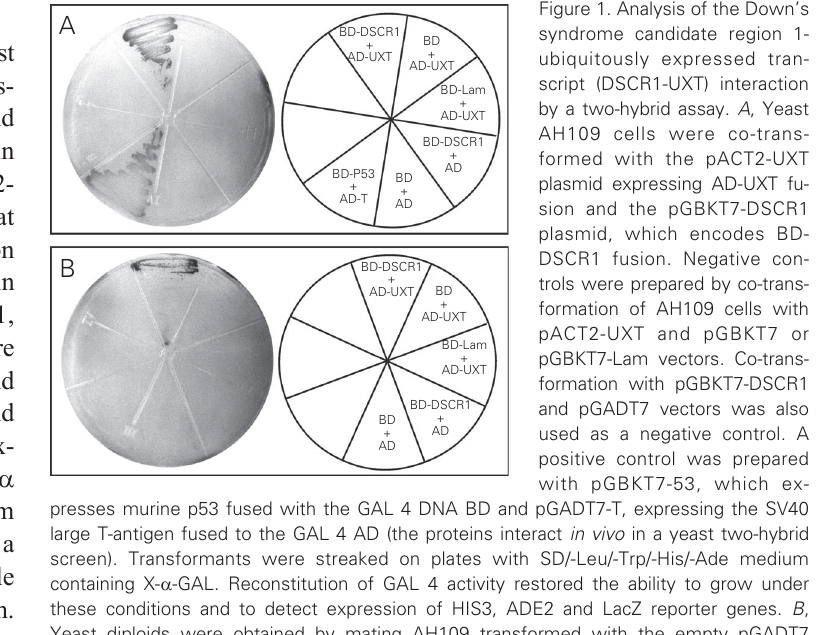
Figure 1. Analysis of the Down’s syndrome candidate region 1- ubiquitously expressed tran- script (DSCR1-UXT) interaction by a two-hybrid assay. A , Yeast AH109 cells were co-trans- formed with the pACT2-UXT plasmid expressing AD-UXT fu- sion and the pGBKT7-DSCR1 plasmid, which encodes BD- DSCR1 fusion. Negative con- trols were prepared by co-trans- formation of AH109 cells with pACT2-UXT and pGBKT7 or pGBKT7-Lam vectors. Co-trans- formation with pGBKT7-DSCR1 and pGADT7 vectors was also used as a negative control. A positive control was prepared with pGBKT7-53, which ex-